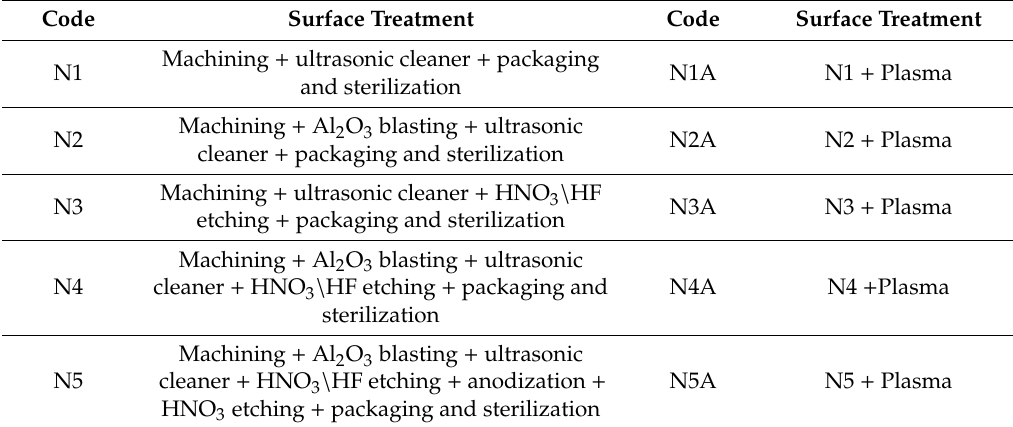
Table 2. List of the surface treatments